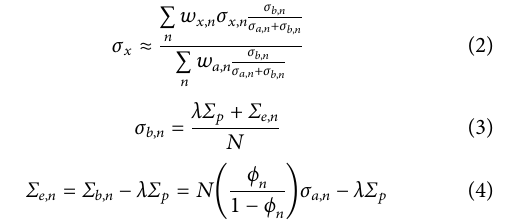
FIGURE 7 Con fi gurations of the VERA4 3D problem.